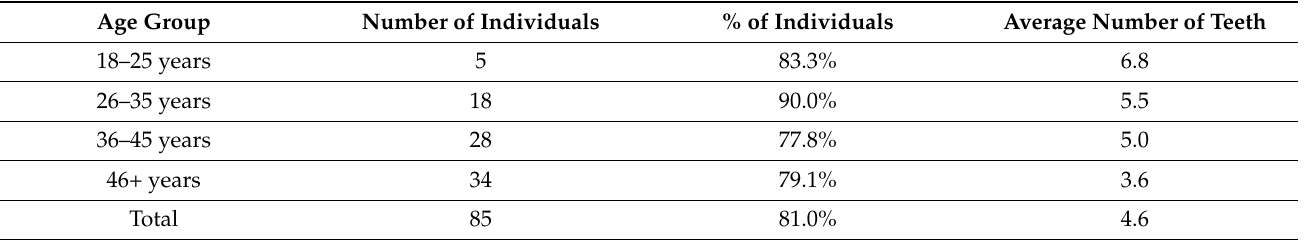
Table 4. Post-mortem tooth loss (mean).